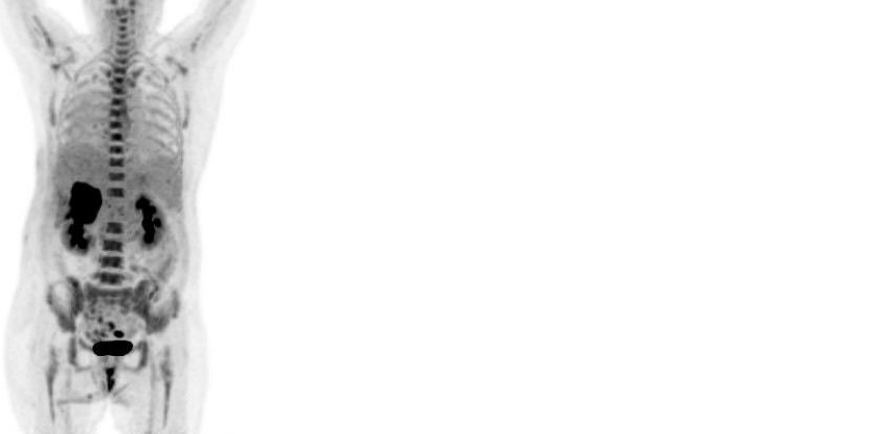
Figure 2. Positron emission tomography scan revealed a mass with intense fluorodeoxyglucose up- take in the right hepatic lobe.